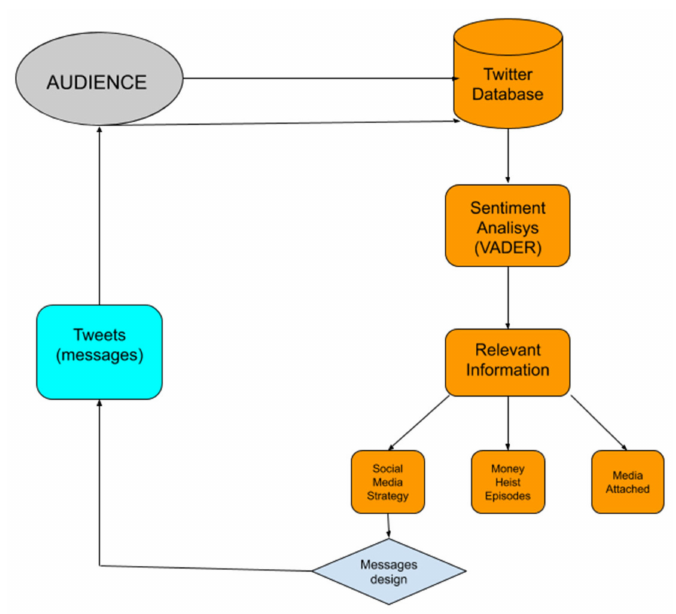
Figure 2. Own elaboration. Addapted from: Zamarreño et al.